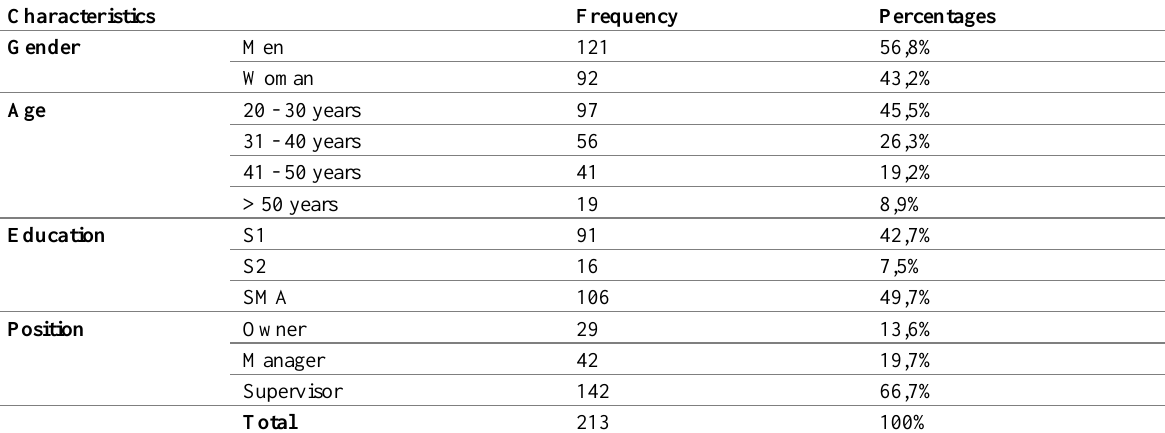
Table 2: Characteristics and Profile of Respondents